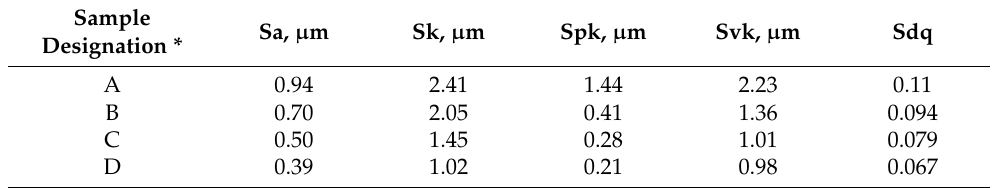
Table 2. Mean values of selected surface texture parameters of particular types of samples (A–D).